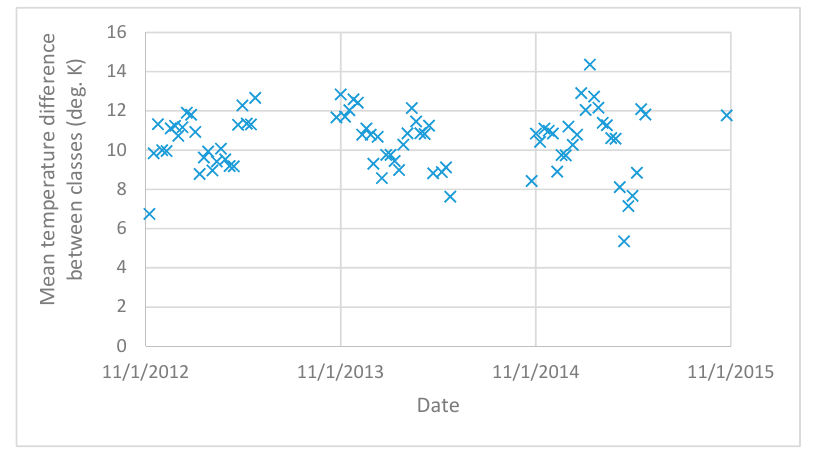
Figure 9. Time series of mean temperature difference between classes (dry land surface temperature—water surface temperature) in the unsupervised classification of Land Surface Temperature (LST) data.